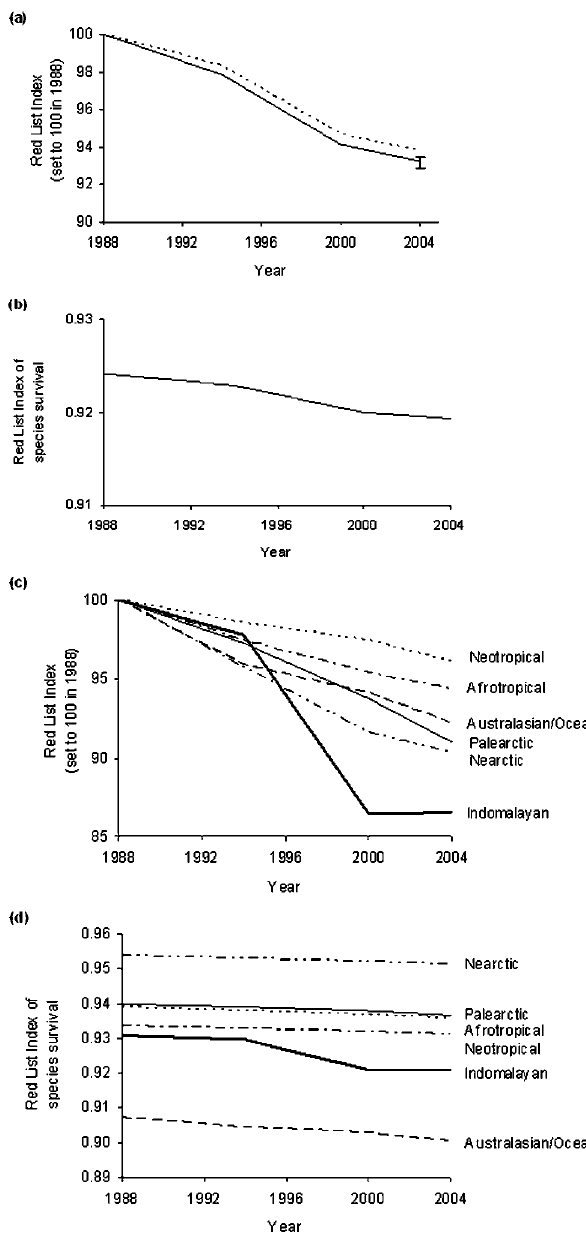
Figure 3. RLIs using the original formulation (left-hand graphs) and the revised formulation (right-hand graphs) for (A–B) the world’s birds (n=9,824 non-Data Deficient species: 99.2% of all extant species) and (C–D) birds in different biogeographic realms. Under the revised formula, an RLI value of 1.0 equates to all species being categorised as Least Concern, and hence that none are expected to go extinct in the near future; an RLI value of zero indicates that all species have gone Extinct. In Figure 3A, the dotted line represents the RLI using the same original formula, but incorporating back-casting using the latest and best-informed evaluations. It results in a substantially higher value by 2004 because the original approach propagates errors resulting from incomplete knowledge in earlier assessments. By 2004, the difference is comparable to the size of the error bars calculated from estimates of the magnitude of the error introduced by delays in knowledge becoming available to assessors [13].